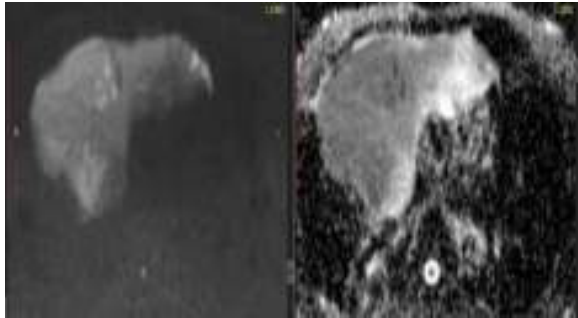
Figure 2. DWI and ADC map sequences show restricted mass in mediastinum